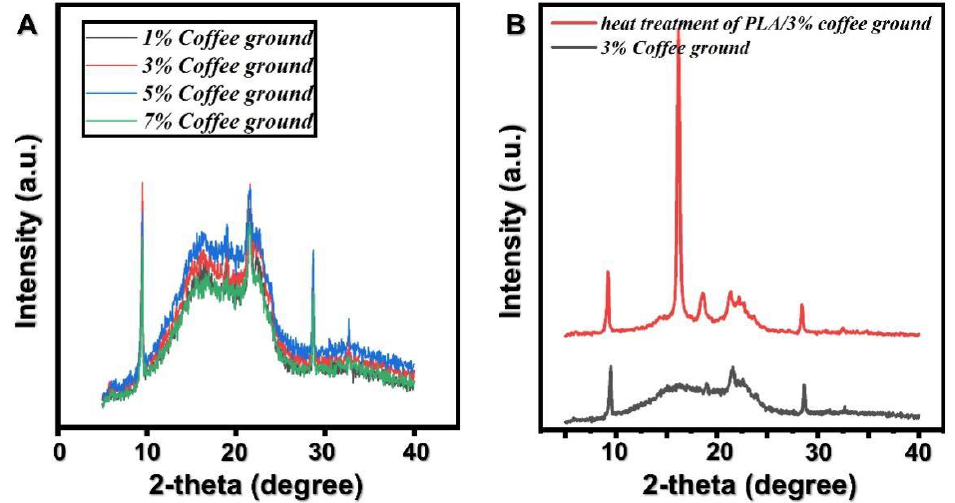
Figure 6. XRD curves of different PLA/coffee grounds 3D printing materials: ( A ) XRD curves of 1%, 3%, 5%, and 7% coffee grounds 3D printing products; ( B ) XRD curves of 3% coffee grounds 3D printing products and thermal treatment of PLA/3% coffee grounds 3D printing products.